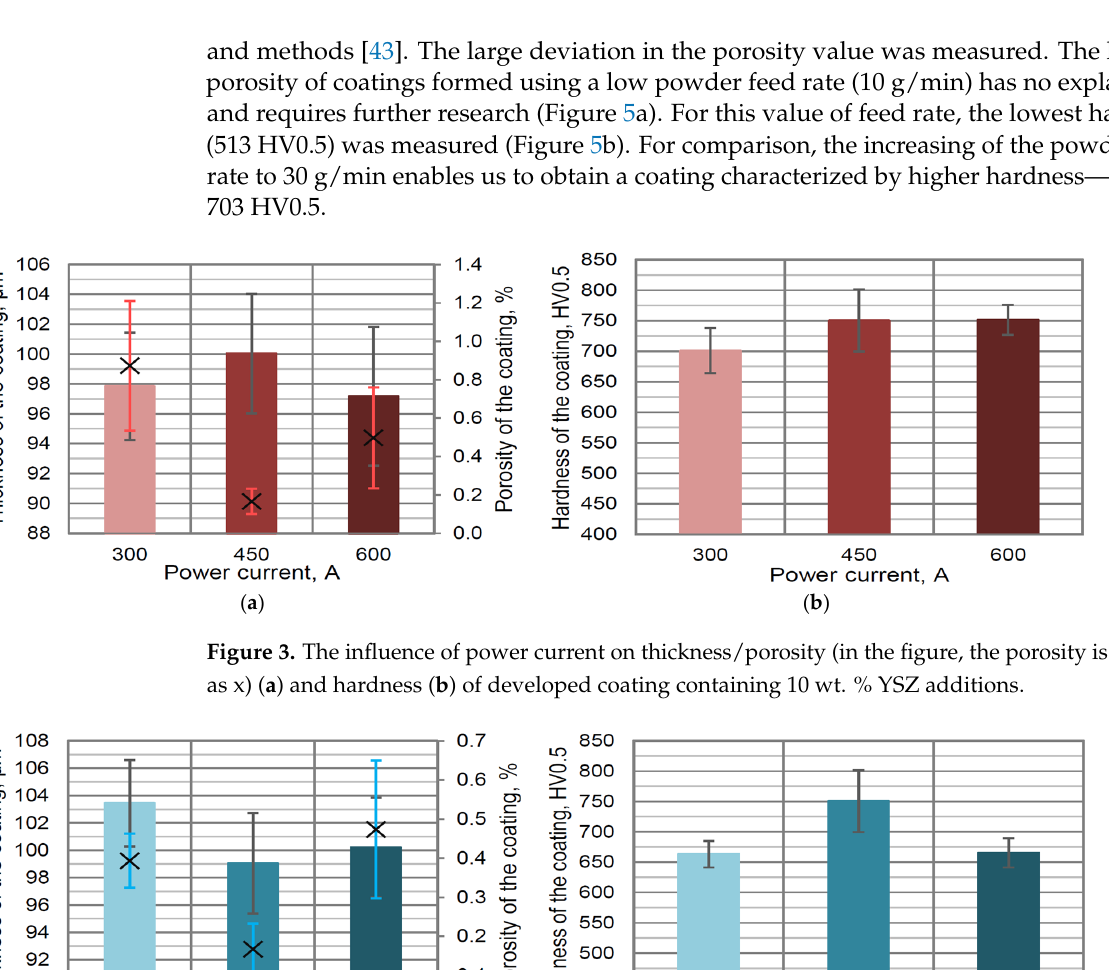
porosity (about 0.5 vol. %). The thickness of the coatings obtained was in the range of 99– 103 μ m (Figure 4a). The highest hardness—750 HV0.5—was measured when the medium value of hydrogen flow (68/5 NLPM) rate was used (Figure 4b). The lower hardness (663 and 665 HV0.5) was measured for two values of the H 2 flow rate, (71/2 NLPM) and (63/10), respectively (Figure 4b).